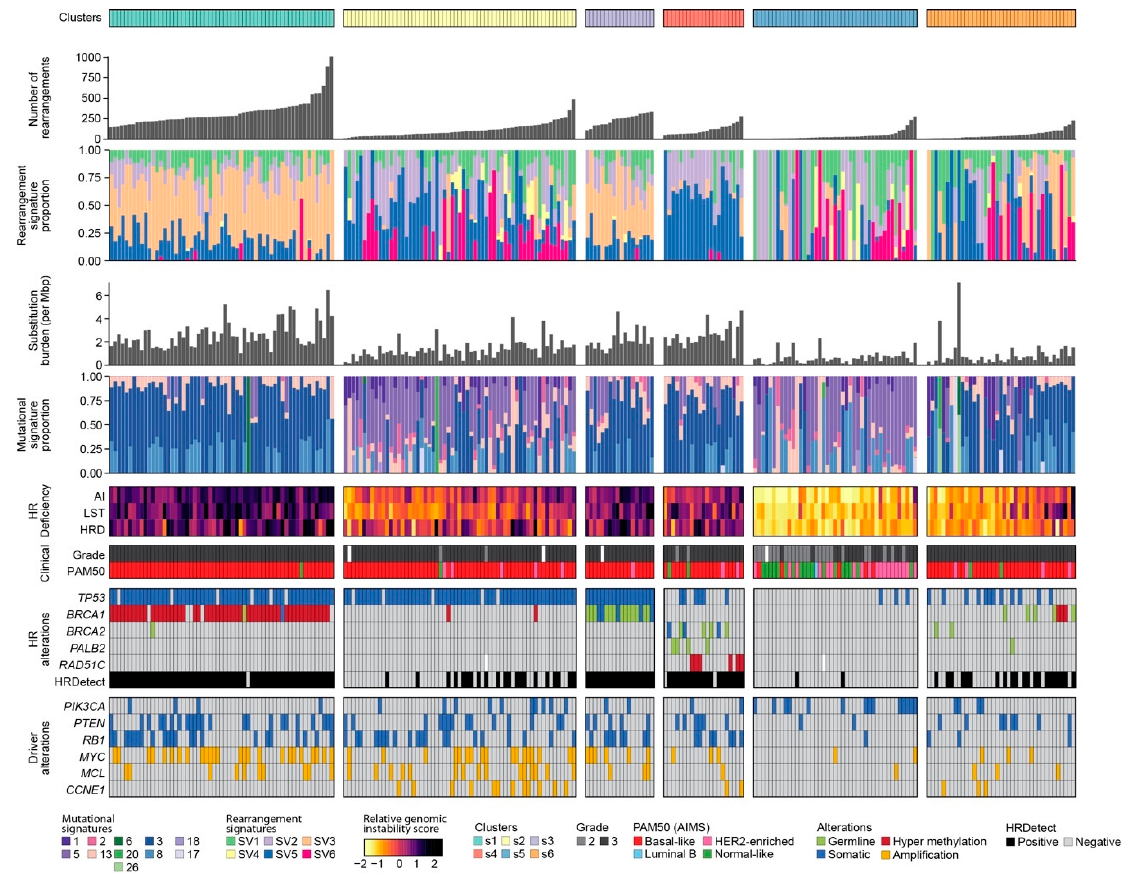
Figure 3. Integrative clusters of triple-negative breast cancer (TNBC). Clusters were derived by applying our permutation- based condCIF to 50 mixed-type features from 241 TNBC patients. Overall levels of genomic instability, as measured by the number of rearrangements and the substitution burden, were different between each cluster. Three clusters (s1, s3, s4) were considered HR deficient, as measured by three genomic signatures (AI, LST and HRD) and HRDetect. Both alterations in HR-related genes, as well as driver genes, varied between the six clusters.